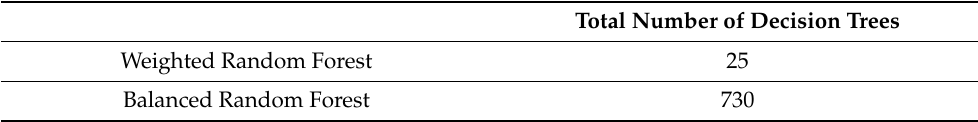
Table 7. Optimal Parameters of random forest models.